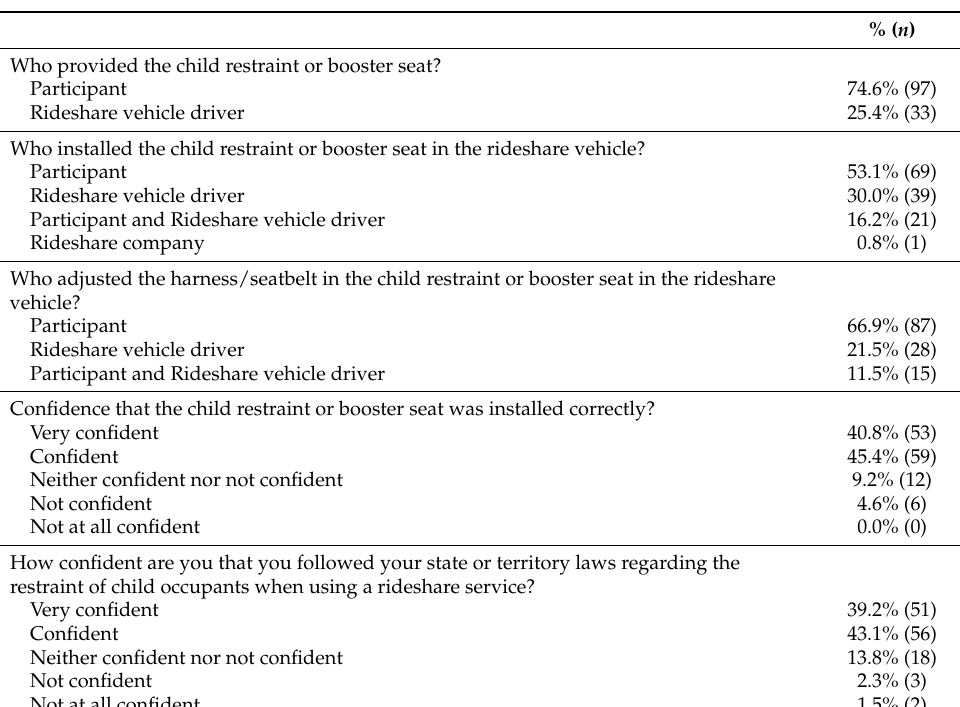
Table 9. Participants’ experience with occupant restraint and regulations in rideshare vehicles ( n =